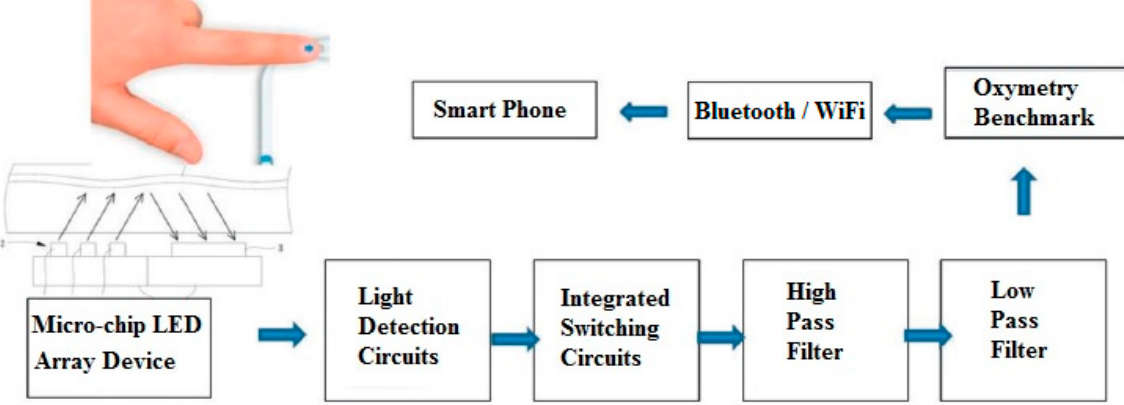
Figure 1. The schematic diagram of the microchip LED array analysis. The blood vessel information comprises blood flow condition, oxygen content and heart rate variability. The application of specific integrated circuits in the microelectrome- chanical system is one of the revolutionary semiconductor components applied in the new era of medical system.